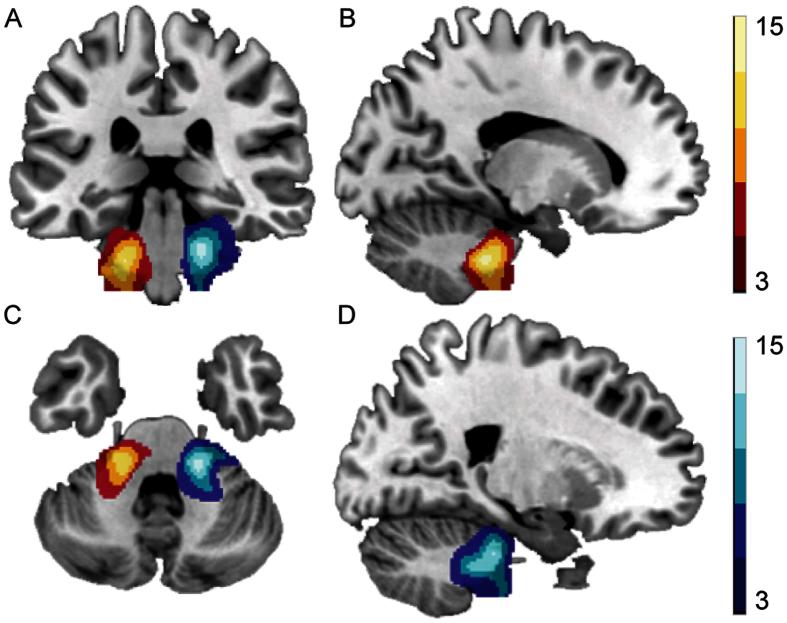
AN tumor volume in left (in red) and right (in blue) UHL patients.